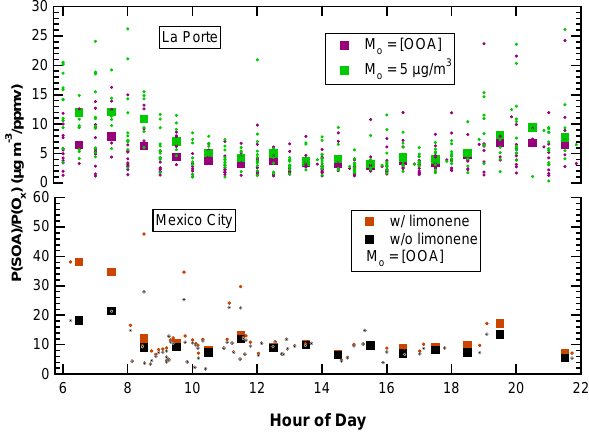
Fig. 6. Calculated P (SOA)/ P (O x ) versus time of day in Mexico City and La Porte. Each small circle represents a calculation using the 30-min average VOC measurements, and the large squares are the averages of all measurements within an hour window of time. For La Porte, the P (SOA)/ P (O x ) calculations shown were made with SOA yields based on both a fixed M o value of 5µg/m 3 (green) and a dynamic M o set equal to the ambient OOA concentration at the time of the VOC measurement (purple). The Mexico City calcu- lations shown were made with and without the limonene measure- ments (with a dynamic M o value in both